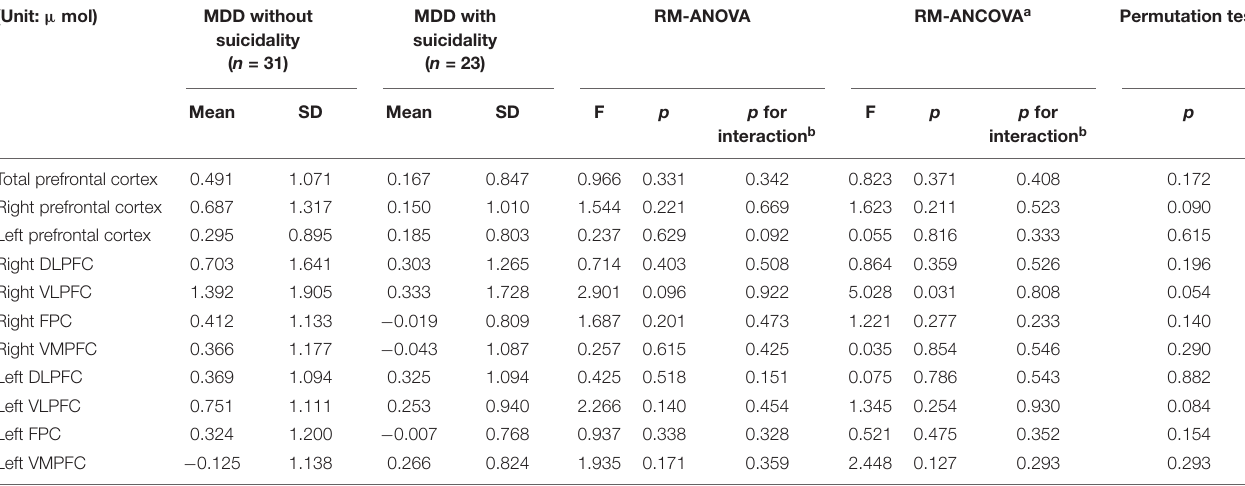
TABLE 3 | Comparison of changes in oxygenated hemoglobin during verbal fluency test between patients with MDD and suicidality and those without suicidality. (Unit: µ mol) RM-ANOVA RM-ANCOVA a Permutation